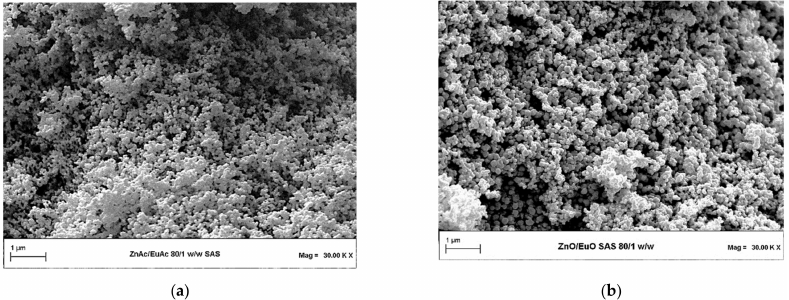
Figure 3. FESEM images of SAS nanoparticles of ( a ) Eu-ZnAc before thermal calcination and ( b ) Eu- ZnO after calcination